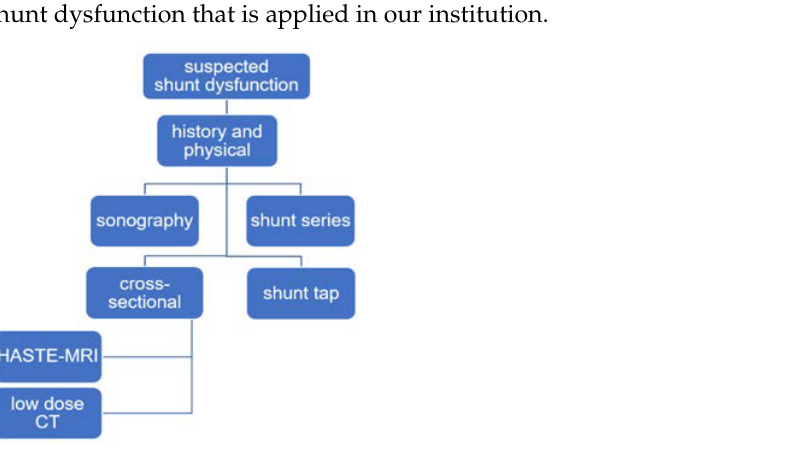
Figure 4. Clinical pathway for suspected shunt dysfunction as used in our department. Second line: For every patient, historical and physical examinations are performed. Third line: Sonography is performed for children if anatomically possible. Shunt series are routinely performed. Fourth line: As a cross-sectional imaging procedure, HASTE-MRI is the preferred modality. If not possible due to availability or patient characteristics, a low-dose CT scan is used. Shunt taps are routinely used to start CSF culture and verify shunt continuity.